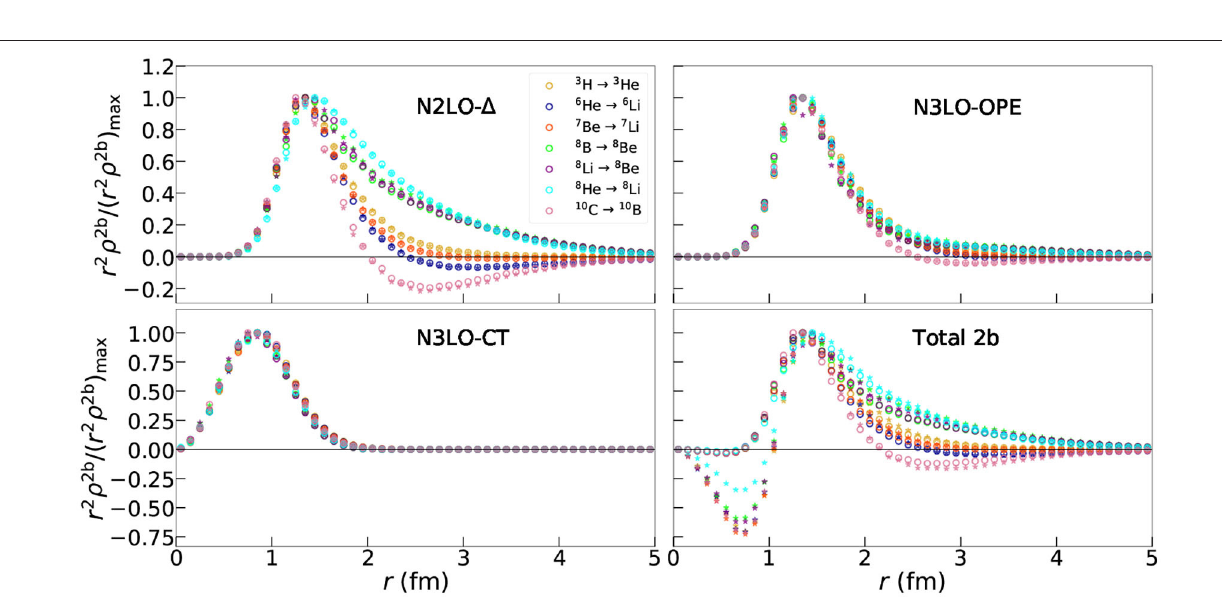
Frontiers in Physics |